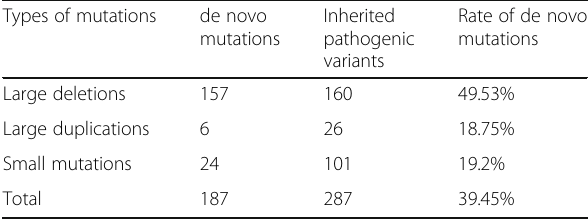
Table 4 Genetic characteristics analysis of DMD gene